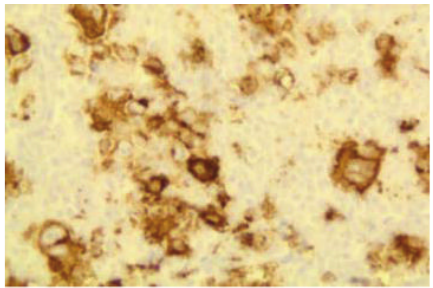
Figure 9: CD15 positivity consistent with CHL (100x).